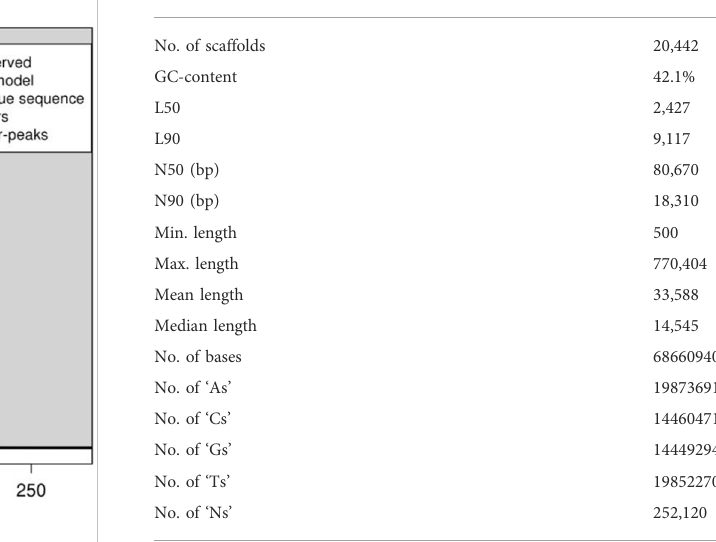
TABLE 1 Statistics of the fi nal fi ltered